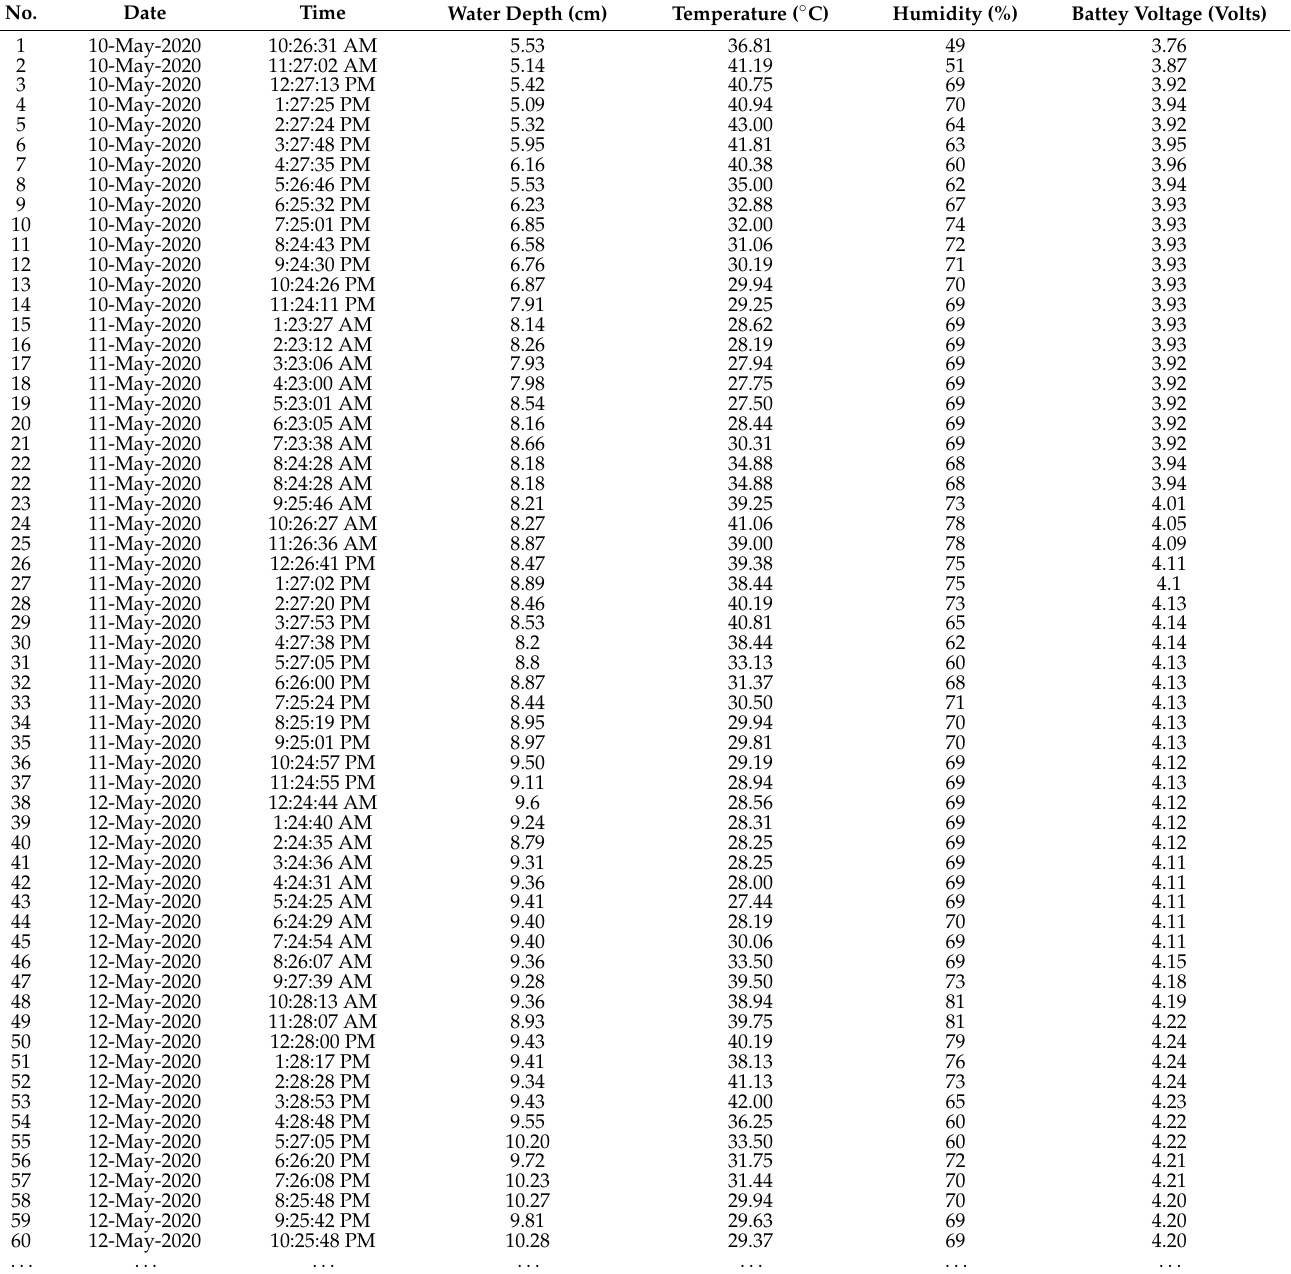
Table A1. Sample dataset from the online database of the low-cost sensor during laboratory test